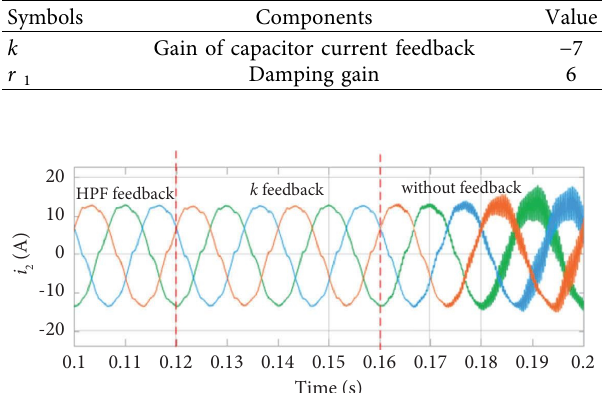
Figure 9: Simulated grid currents with diferent capacitor current feedback methods when L g � 0 and C g � 0.